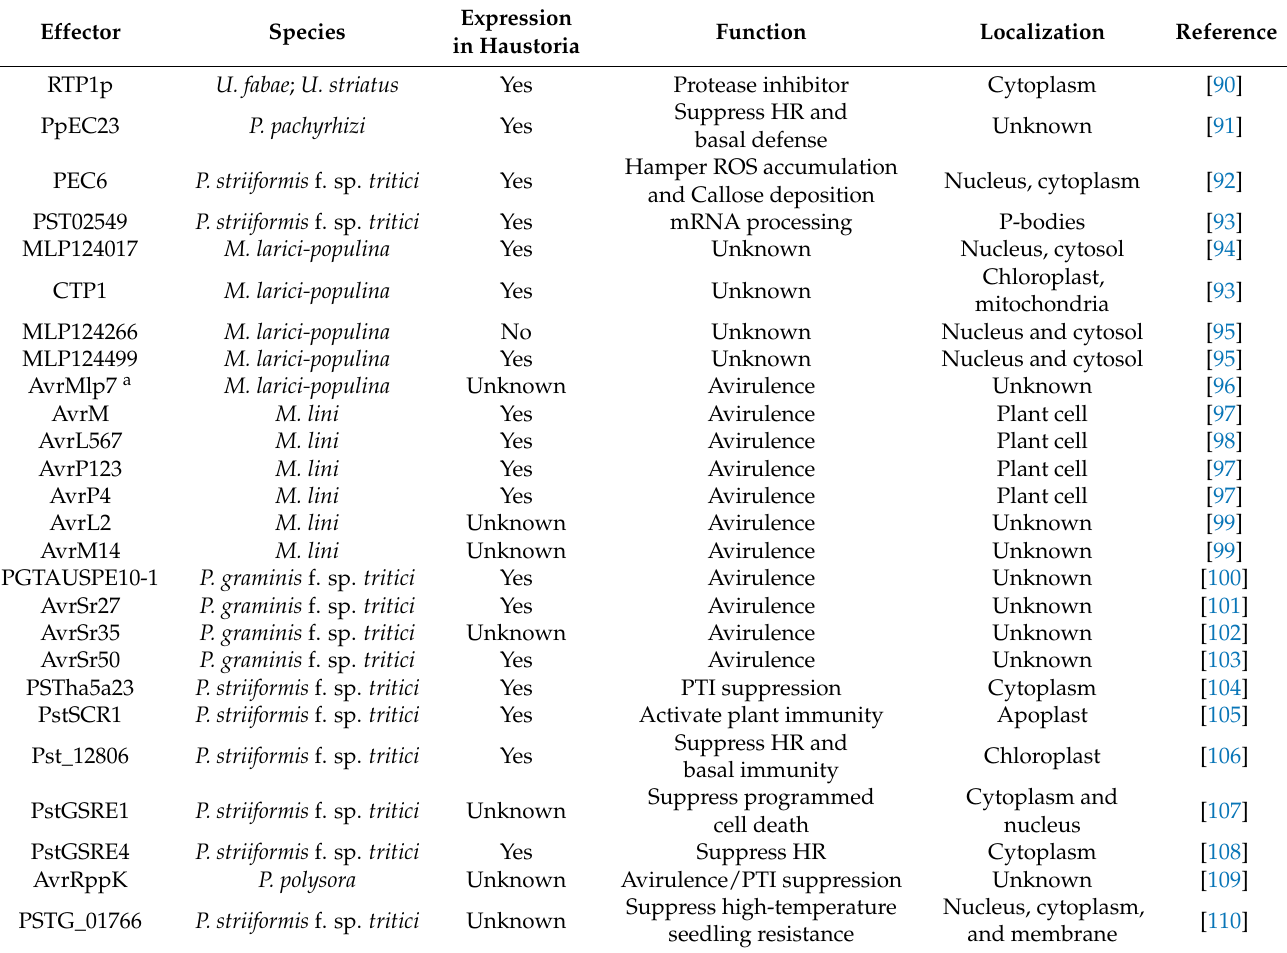
Table 3. Characterized effectors in rust